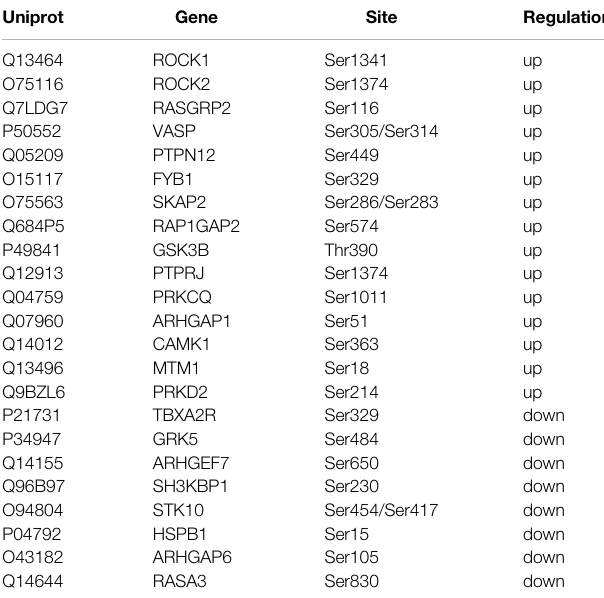
TABLE 1 | Different phosphorylated proteins in FF + collagen- vs collagen-treated platelets. Uniprot